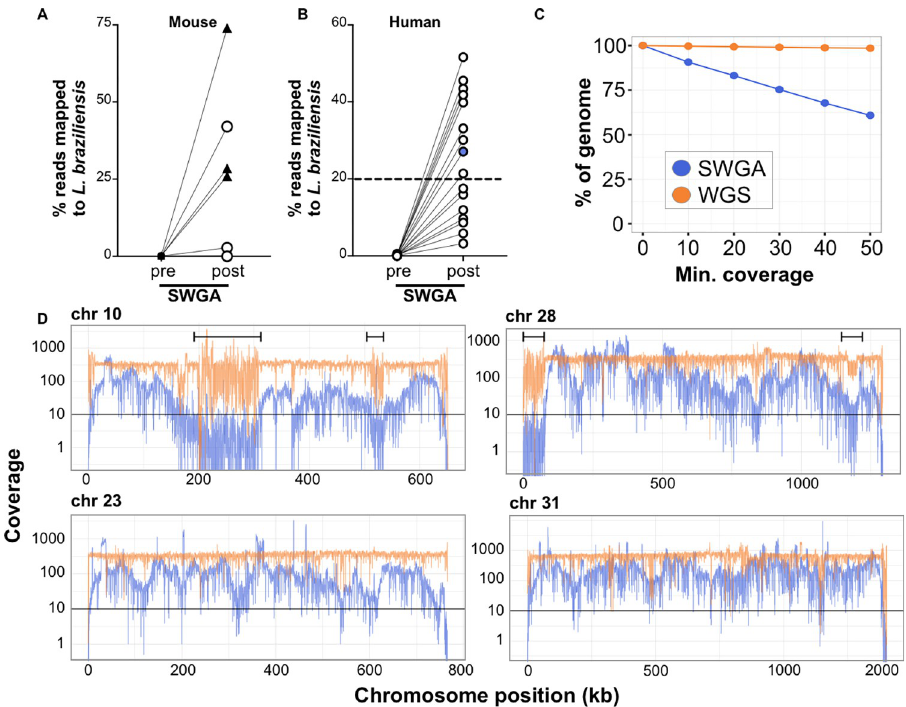
Fig 2. In vivo validation of SWGA for Leishmania . Percentage of reads mapping to L . braziliensis genome in DNA from (A) infected mouse ears (n = 3 animals infected with L . major , triangles; n = 5 animals infected with L . braziliensis , circles) or (B) patient lesion biopsies, sequenced before (pre) and after (post) SWGA. Data shown are from the SWGA primer set the yielded the best amplification for each sample. (C) Genome coverage for SWGA data from a single patient sample (patient #7, blue point from panel B). (D) Coverage of four selected L . braziliensis chromosomes in SWGA data from a single patient (#7; blue lines) compared to whole genome sequencing (WGS) of pure, cultured L . braziliensis (orange lines). Data shown in panel C and D are merged from all SWGA primer sets to maximize coverage.